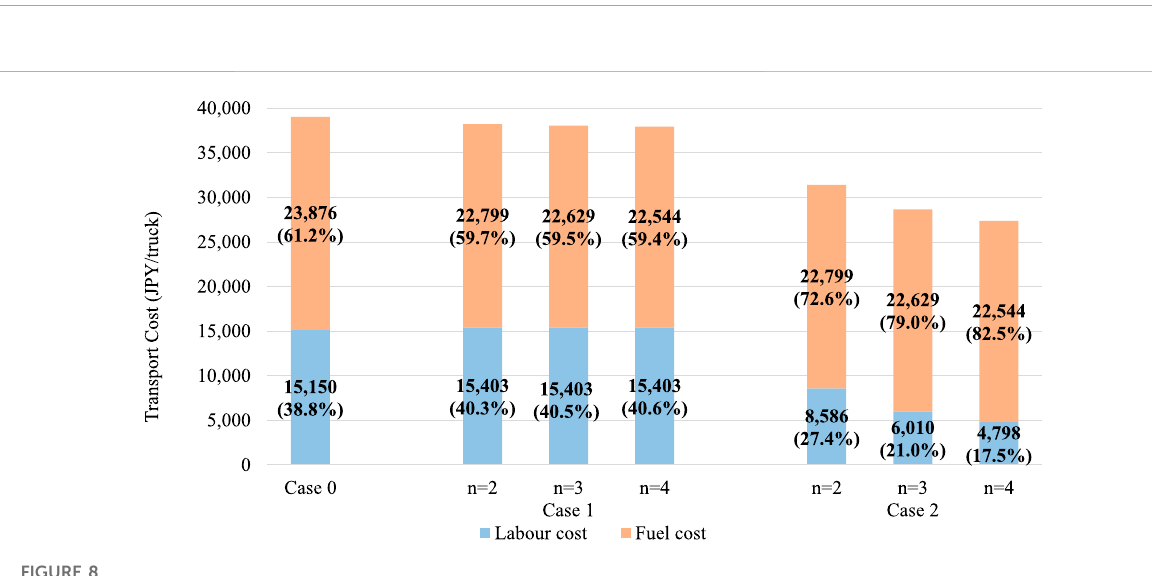
Frontiers in Future